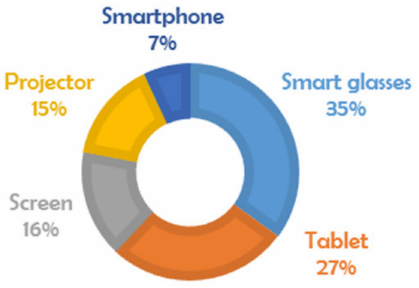
Figure 7. Visualization devices for the application of